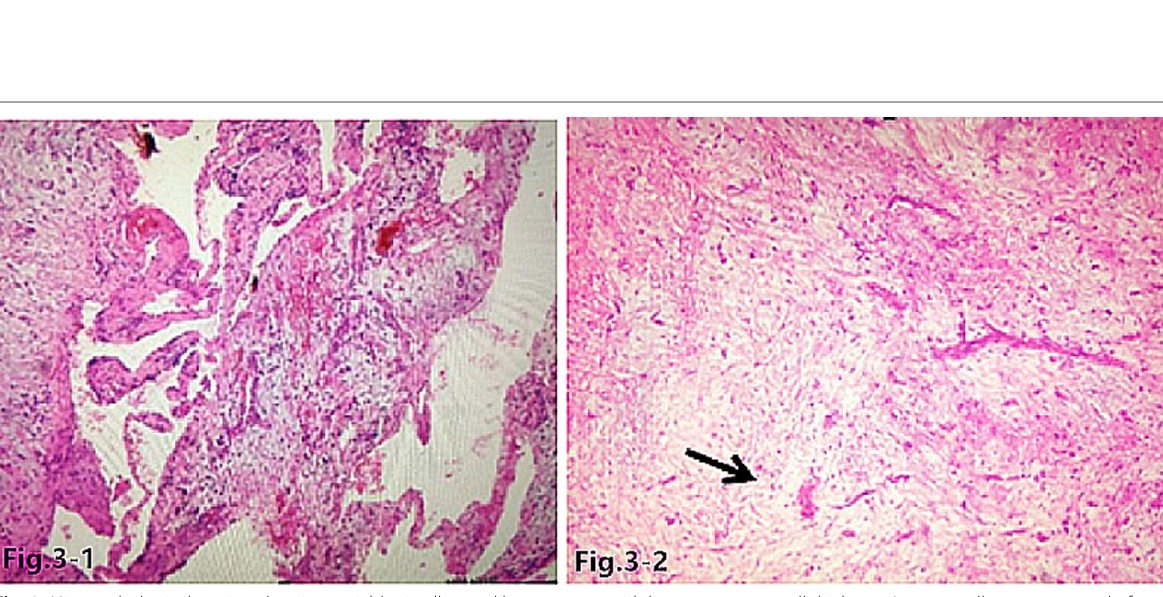
Fig. 3 Histopathological section showing variably sizedlumen like structures with heterogeneous wall thickness. Lumen walls are composed of fibrous connective tissue with a monolayer of flattened endothelial cells in the inner village. Myxoid degeneration can be seen locally in the tumor (Black arrow; H&E, ×